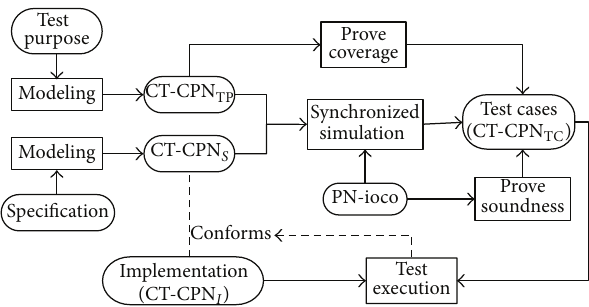
Figure 1: The framework of IOCO test selection method with CPN